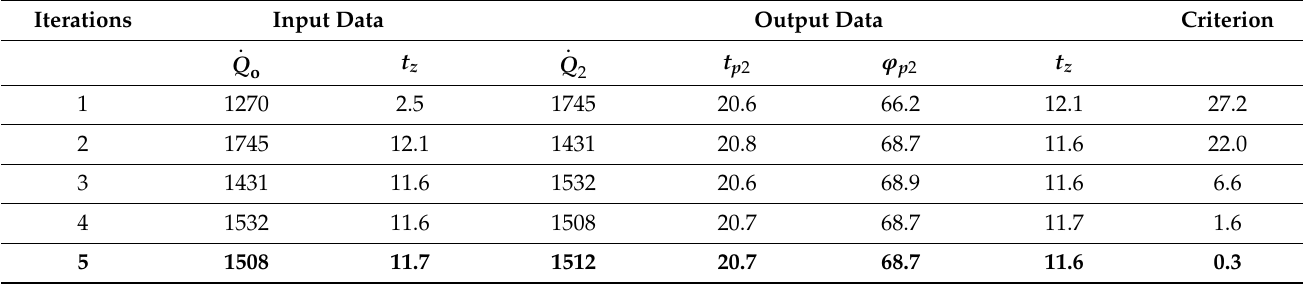
Table 5. Iterative calculations of the